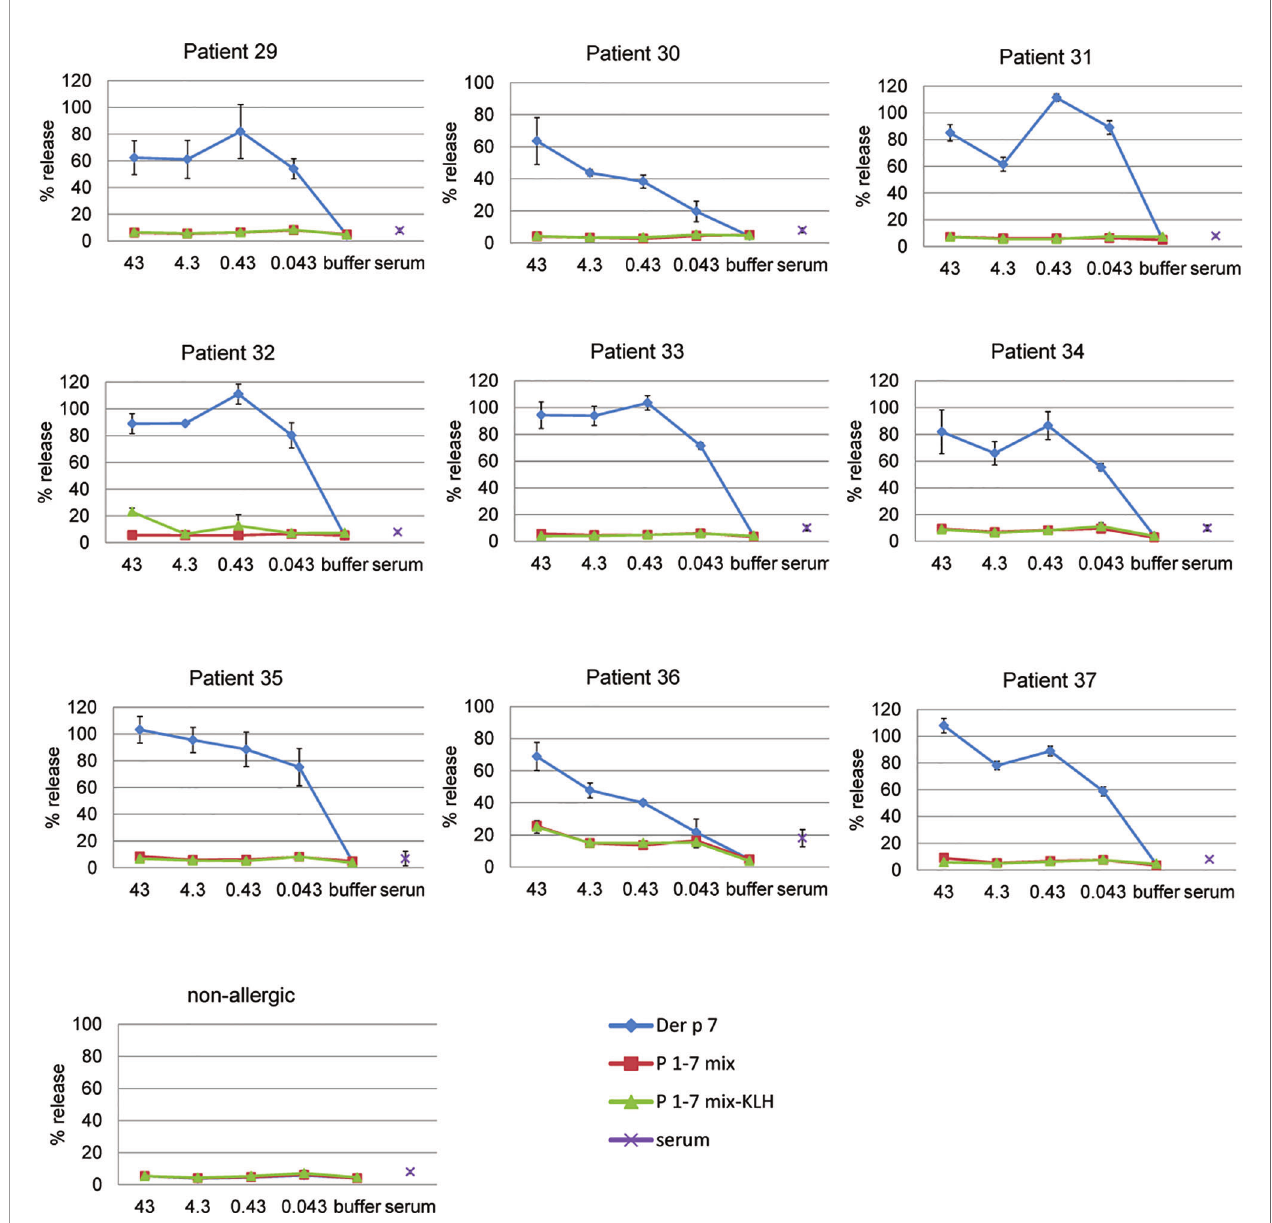
FIGURE 4 | Allergenic activity of rDer p 7 and Der p 7-derived peptides as determined by basophil activation. RBL cells transfected with human Fc ϵ RI were loaded with serum IgE of HDM-allergic patients (patients 29 – 37) or with serum IgE from a non-allergic person and were then exposed to decreasing concentrations (43, 4.3, 0.43, and 0.043 nM) of rDer p 7, or equimolar concentrations of the peptide mix (P1-7 mix) or a mix of KLH coupled peptides (P1-7 mix-KLH). b -hexosaminidase releases are displayed as percentages of total b -hexosaminidase on the y-axes and represent the mean of triplicates±